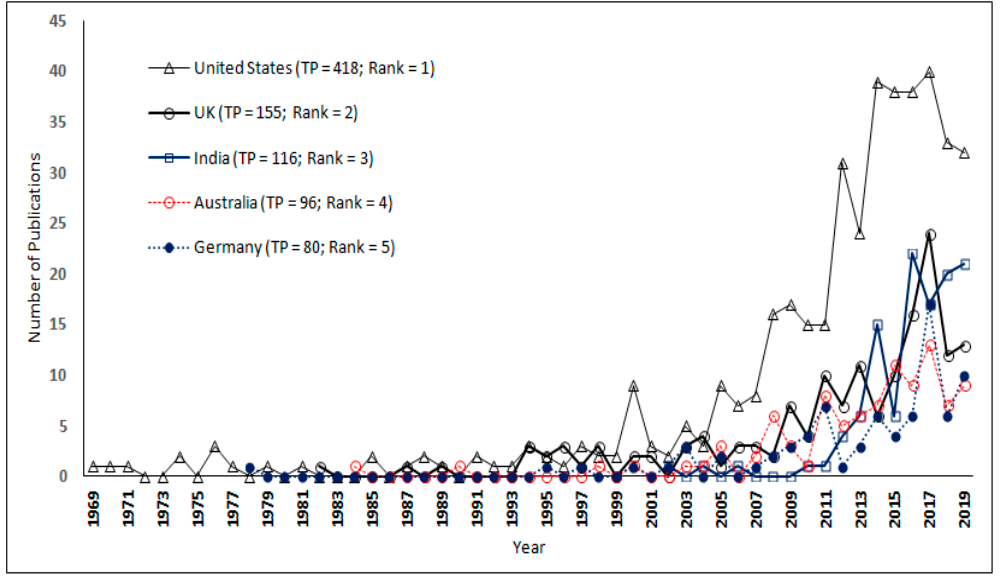
Figure 3. Progression of the research publications by the top five countries.